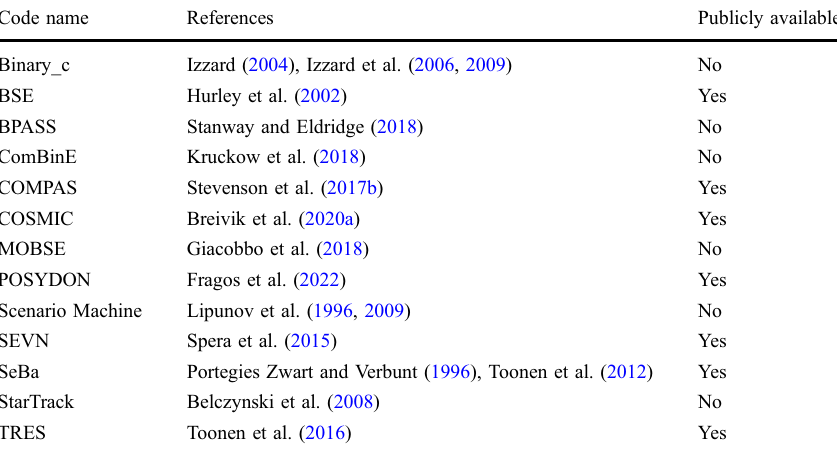
Table 5 Population synthesis codes used by the community at the time of